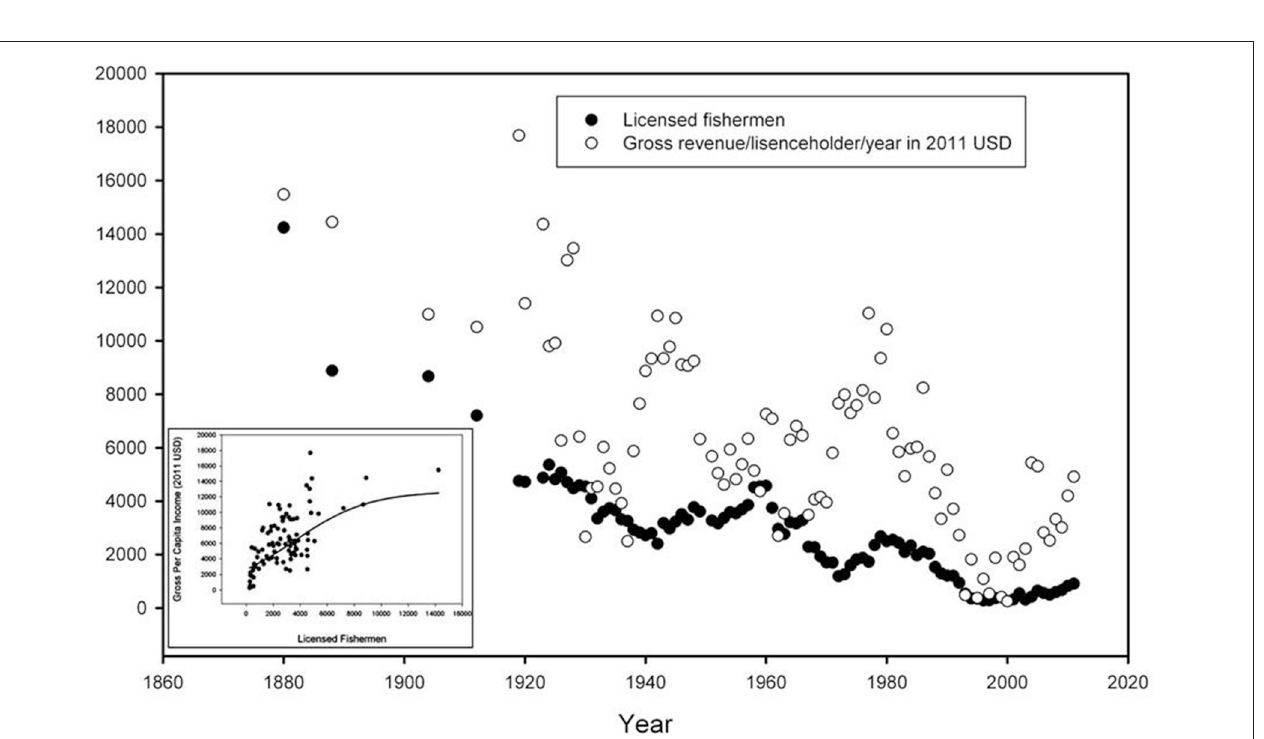
Frontiers in Marine Science |